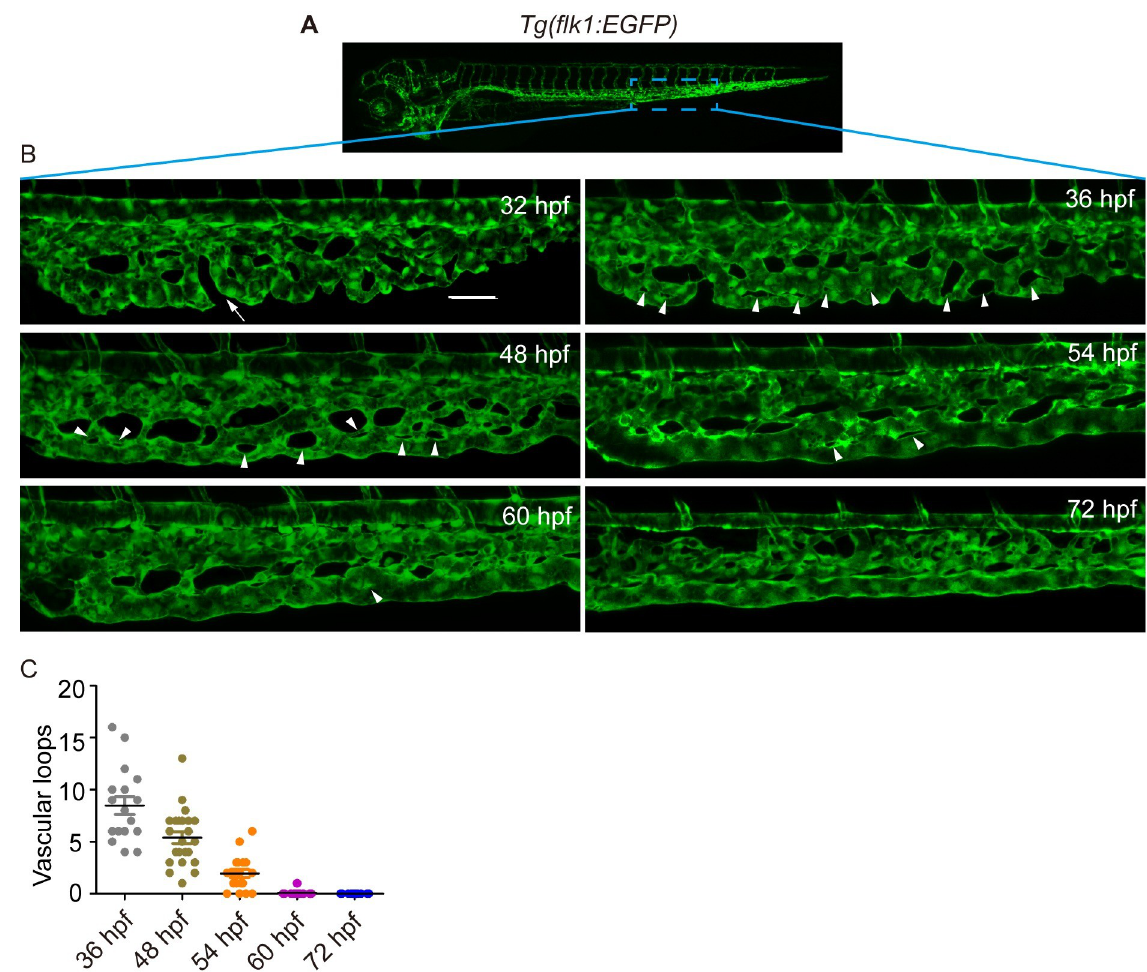
Fig 1. The zebrafish caudal vein formation involves vascular remodeling. (A) A sketch map of the region. (B) Confocal images of the caudal vasculature of zebrafish embryos. The arrow points to ventral CVP capillaries without connection. Arrowheads point to vascular loops. Scale bar: 50 μ m. (C) Quantification of the number of vascular loops in the CV: 36 hpf, n = 17 embryos; 48 hpf, n = 23 embryos; 54 hpf, n = 19 embryos; 60 hpf, n = 22 embryos; 72 hpf, n = 13 embryos.